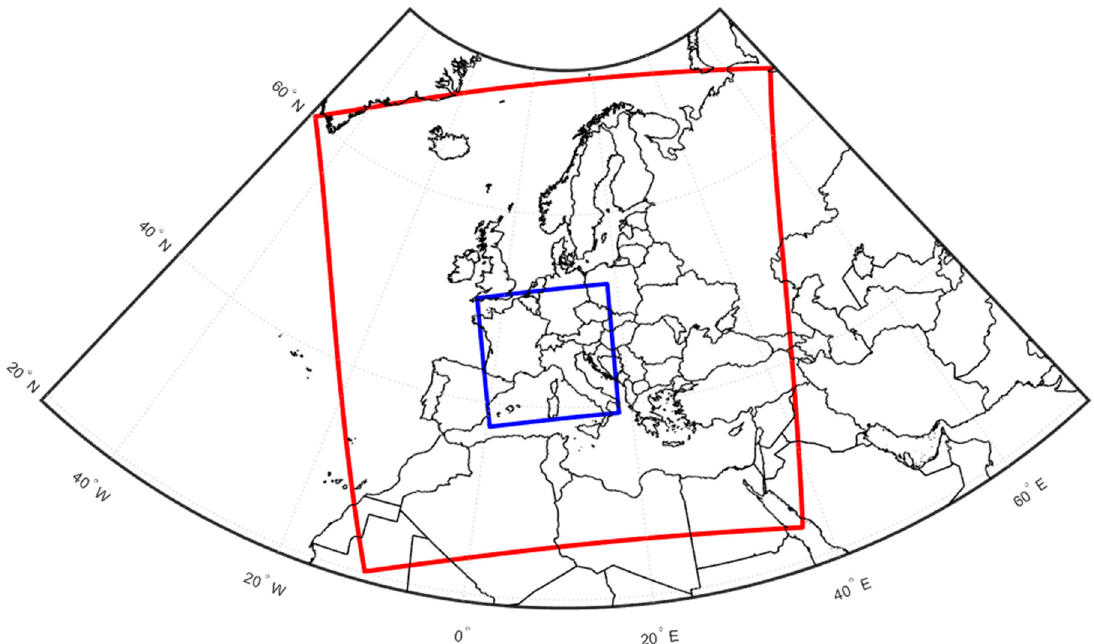
Figure 1. Analysis domains for EUR-11 (red box) and ALP-3 (blue box).